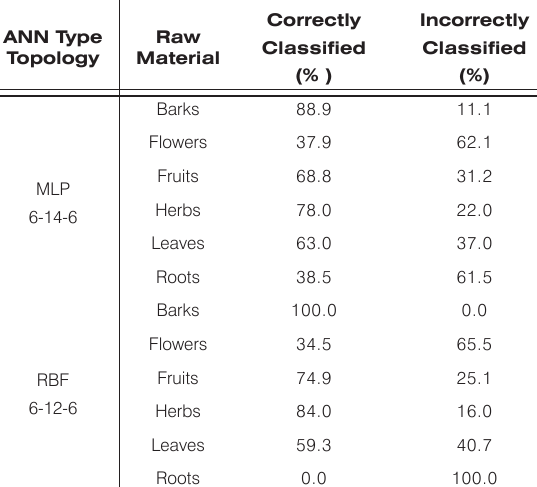
Table 2. Summary statistics for the applied architectures of ANNs.